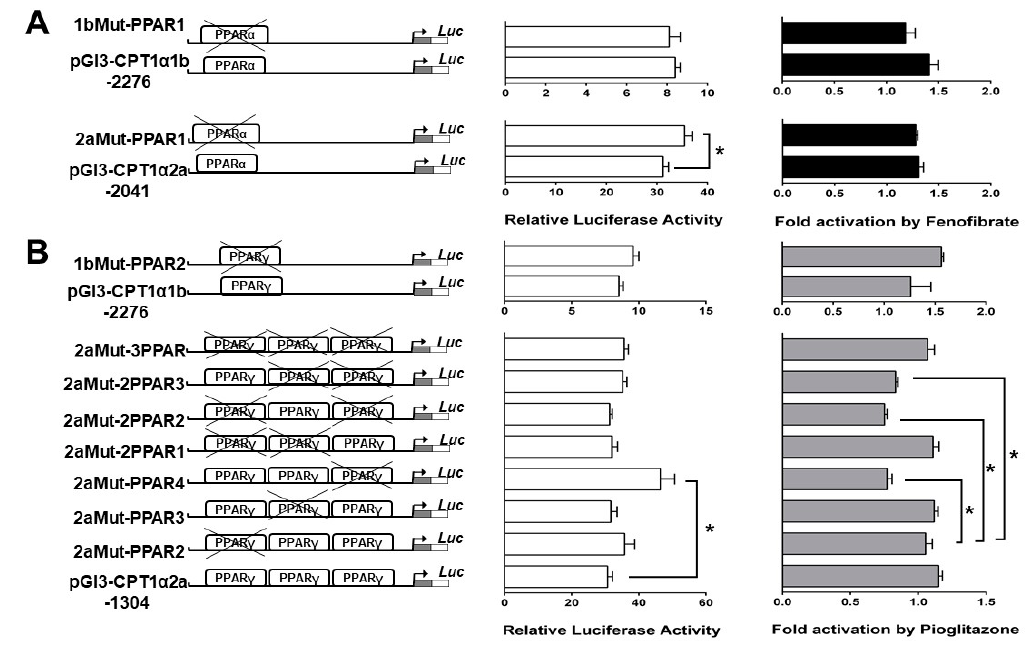
Figure 6. Analysis of putative PPAR binding sites by site-directed mutagenesis. Site-mutation constructs are presented in the left panel. Promoter activity of constructs is presented in the middle. Promoter activity treated with agonist was presented in the right panel. ( A ) site-mutations of PPAR α binding sites on pGl3-CPTI α 1b-2276 and pGl3-CPTI α 2a-2041 vectors ( B ) site-mutation of PPAR γ binding sites on pGl3-CPTI α 1b-2276 and pGl3-CPTI α 2a-1304 vectors. Values represent the ratio between firefly and renilla luciferase activities, normalized to the control plasmid pGL3-Basic. Bars are the mean ± SEM of three independent experiments (Student’s t -test, * p < 0.05).